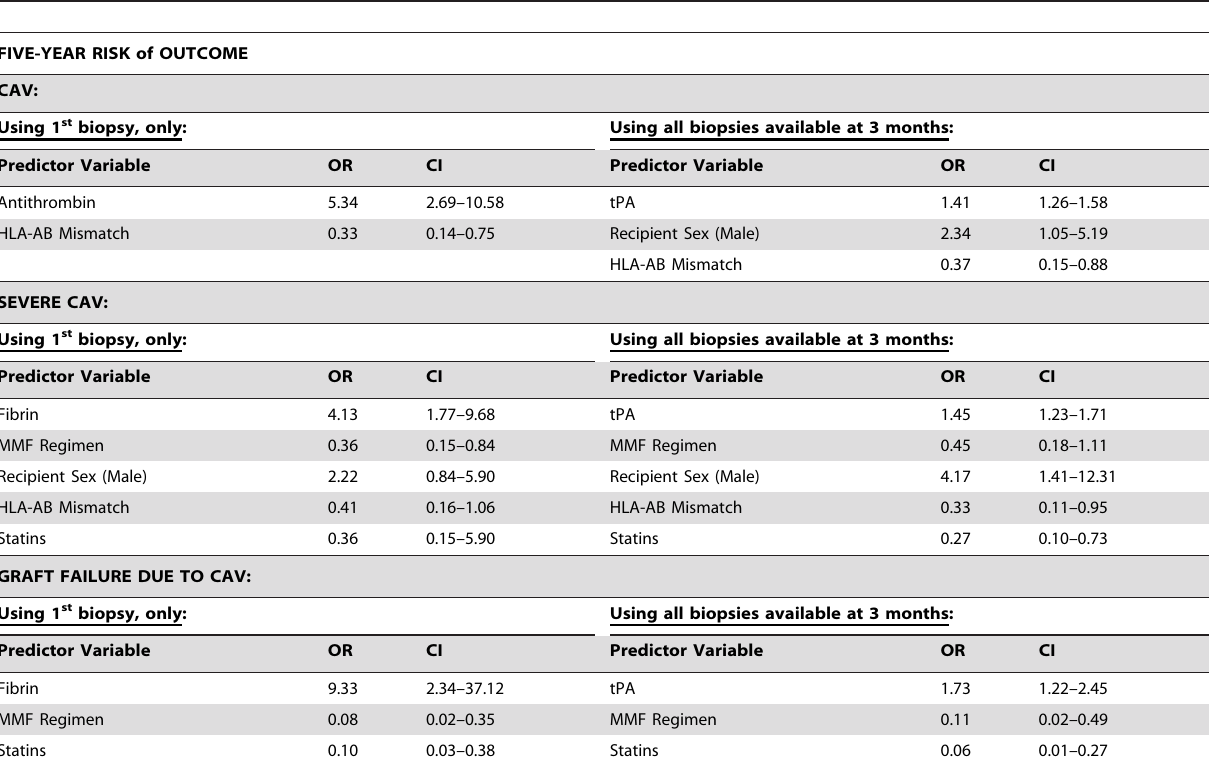
Table 4. Final multivariate logistic regression models using first-biopsy-only or three-month biopsy data to predict CAV, severe CAV, and graft failure due to CAV at five years